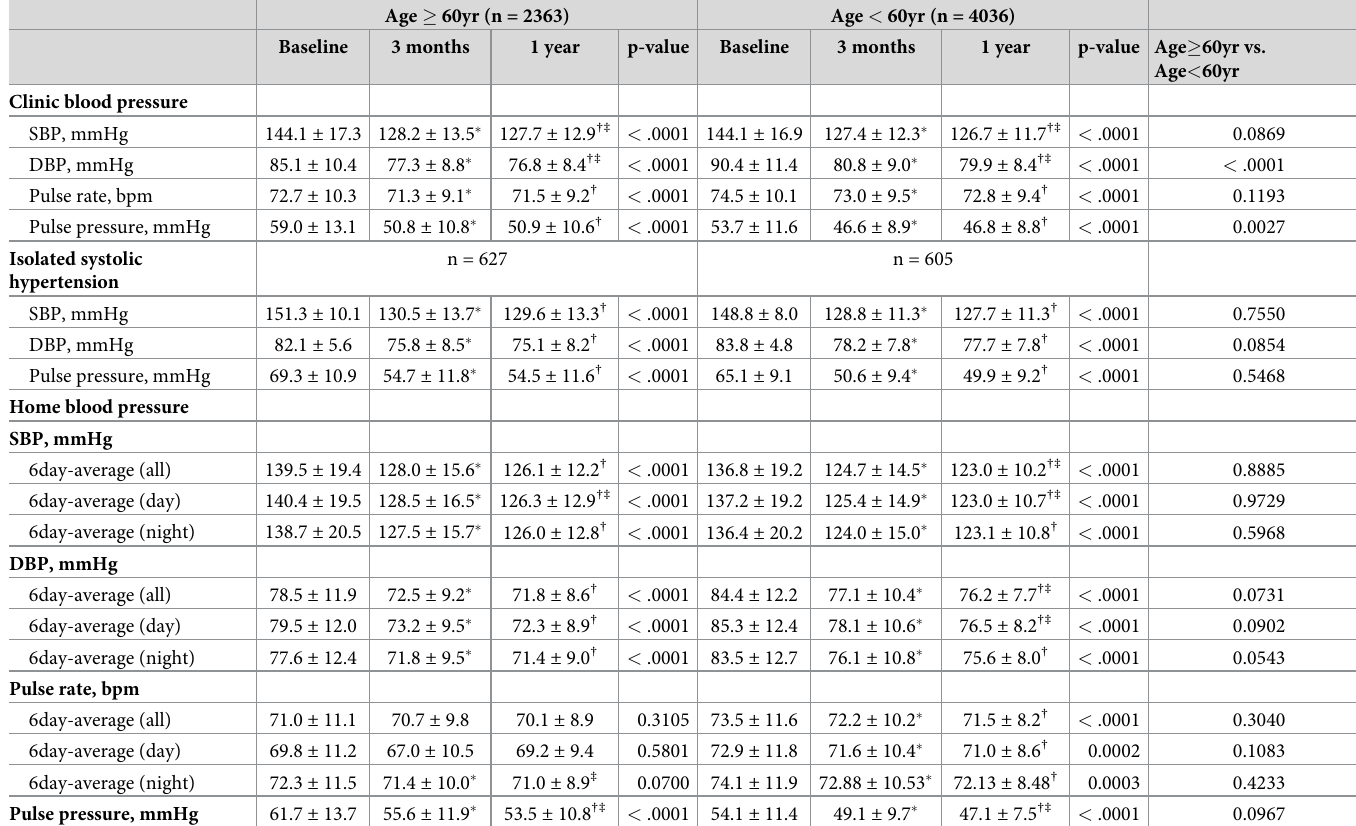
144.1 ± 17.3 to 127.7 ± 1 2.9 mmHg and clinic DBP from 85.1 ± 10.4 to 76.8 ± 8.4 mmHg (all p < 0.0001) (Table 2). The heart rate was reduced from 72.7 ± 10.3 to 71.5 ± 9.2 beats/min at 1 year of fimasartan treatment (p < 0.0001). This efficacy of fimasartan in elderly patients was consistent regardless of patient’s sex, underlying medical condition, or comorbidities. Table 2. Change of blood pressure at clinic and home during 1 year